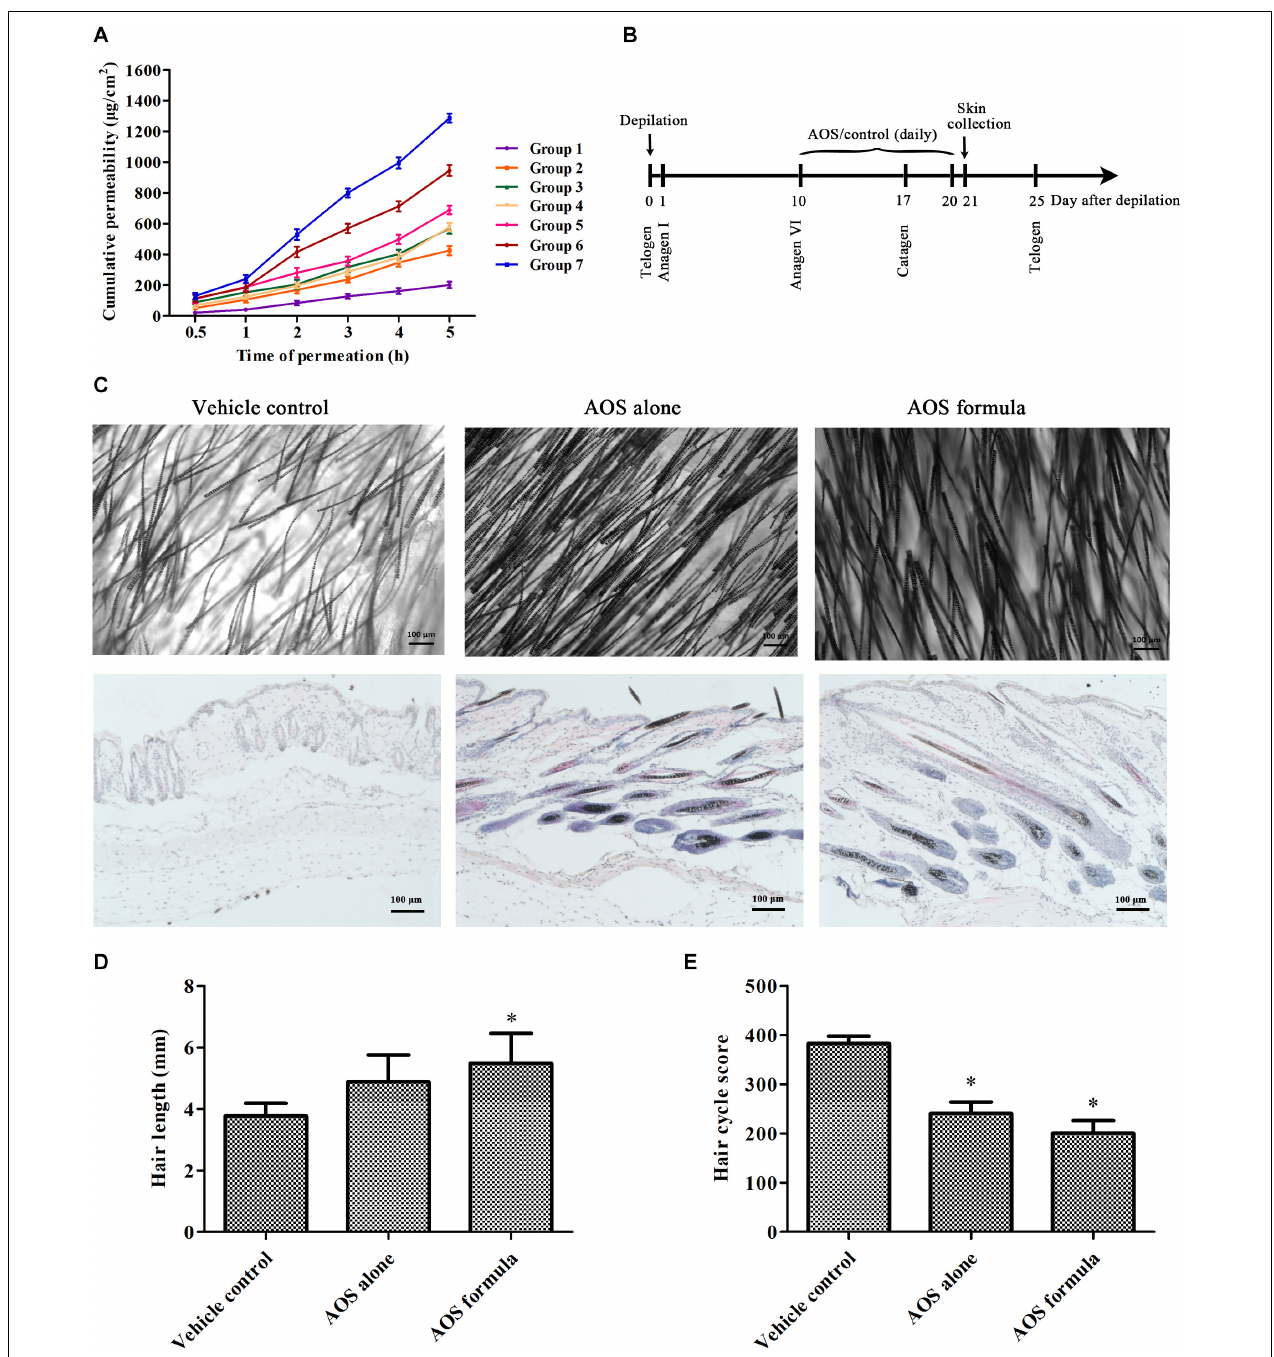
FIGURE 4 | Effects of algal oligosaccharide (AOS) on hair growth of mice. (A) In vitro transdermal permeation of different AOS penetration-enhancing formula. The abdomen skin of Sprague–Dawley rats was fixed in a Franz diffusion pool. Five hundred microliters of different AOS penetration-enhancing formulas was adopted as the donor solution. The amount of AOS (DP2) in the receiving tank was determined by the dinitrosalicylic acid method. The cumulative permeation per area of the skin ( Q n , µ g/cm 2 ) was calculated. The experiment was repeated three times. (B) Scheme of the animal experiment. The back skin of C57BL/6 mice ( n = 6) was treated with vehicle [2% glycerol and 1% polyethylene glycol (PEG) 400], AOS alone (1% AOS DP2), or AOS formula (1% AOS DP2 with 2% glycerol and 1% PEG 400) at anagen stage for 10 days. (C) Effects of AOS on hair follicle growth cycle and hair density. Representative morphological (top) and histological (bottom) images of skin tissue at day 21 are shown. (D) Effects of AOS on hair length. The length of randomly plucked hairs ( n = 30) was measured. (E) Calculation of the hair cycle scores. Fifty hair follicles identified on sections were scored for each mouse, and five mice were used for each group. Each stage of the hair cycle has been scored as follows: anagen V–VI = 100, early catagen = 200, mid catagen = 300, late catagen = 400. The value indicates the mean hair cycle score per group ( ∗ p < 0.05).